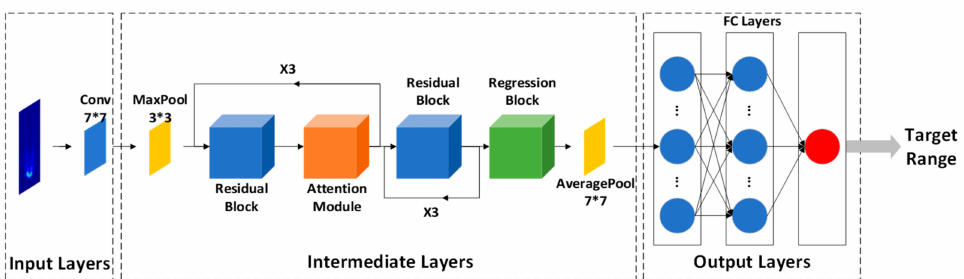
Figure 12. Algorithm flowchart using the attention-based ResNet regression